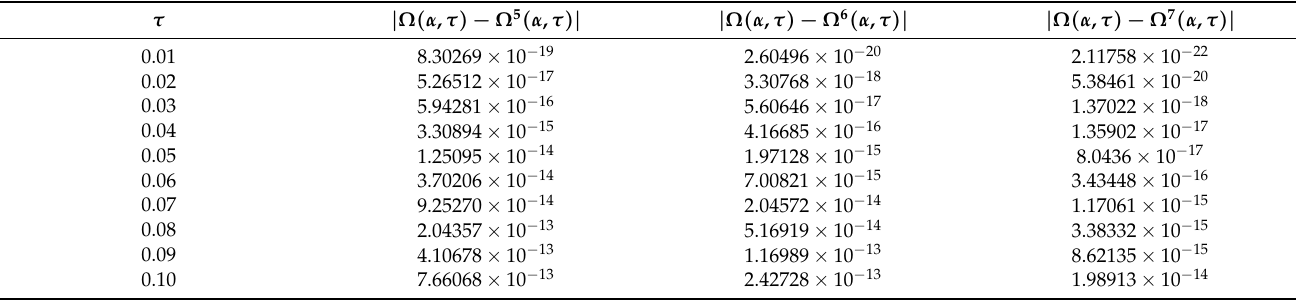
Table 10. The Abs. E of Problem 1 at α = 0.003 when ¯ h = 1.0 in the range τ ∈ [ 0, 0.10 ]